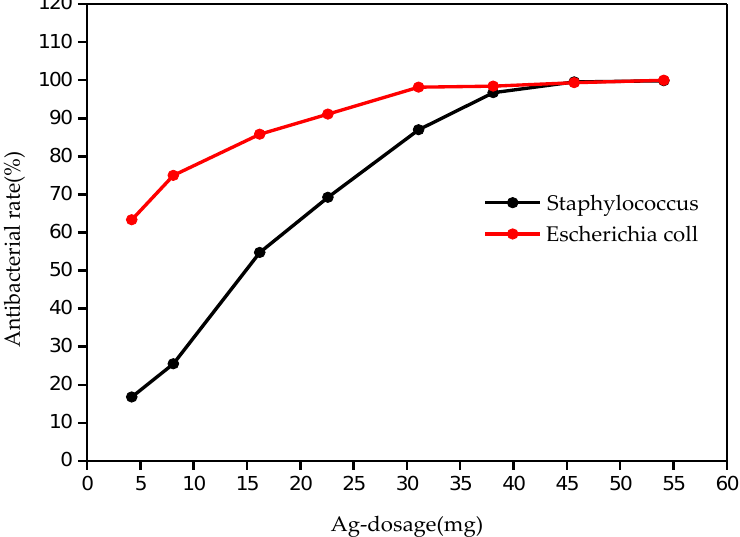
Figure 9. Relationship between the antibacterial rate and the Ag dosage on the silver-deposited cotton.